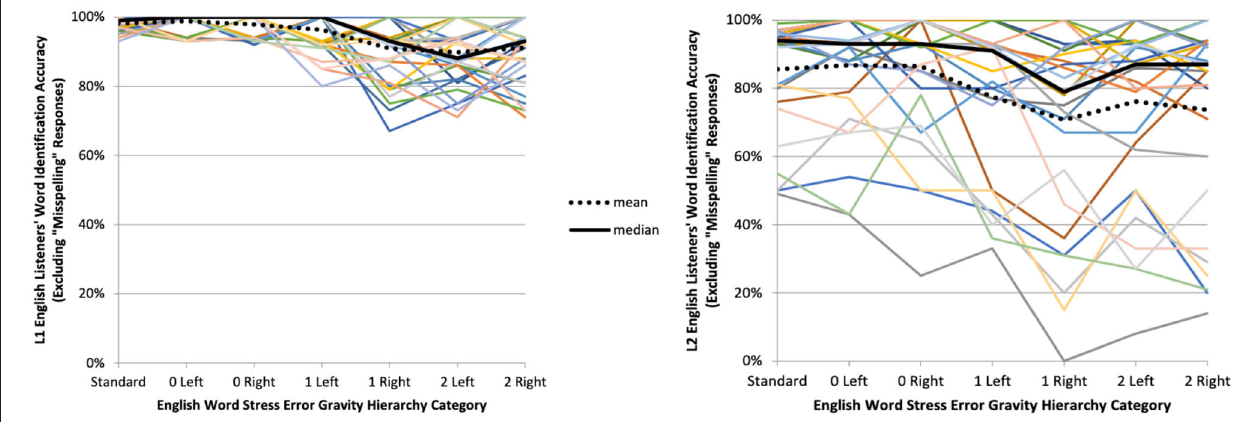
FIGURE 7 | (Typed) word identification accuracy (excluding misspellings) by Hierarchy category for L1 ( n = 38, left) and L2 ( n = 31, right) English listeners.